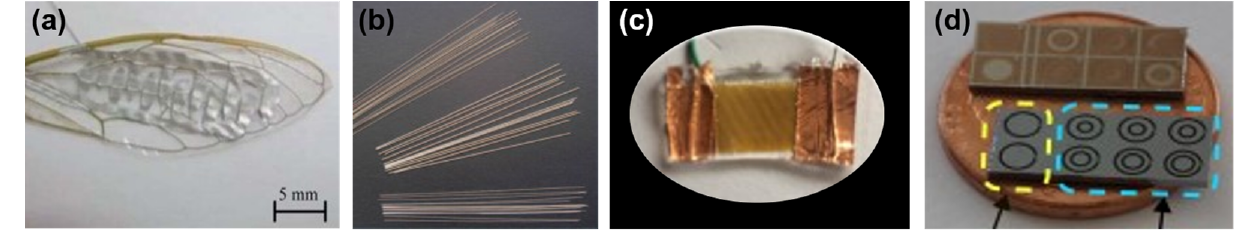
Figure 6. ( a ) Piezoelectric fibers on cicada wings. Reprinted with permission from Ref. [57]. Copyright 2014, Royal Society of Chemistry. ( b ) PZT microfibers. Reprinted with permission from Ref. [58]. Copyright 2012, Elsevier. ( c ) Piezoelectric nanogenerator (PENG). Reprinted with permission from Ref. [59]. Copyright 2019, MDPI. ( d ) Concentric ring boss harvesters (CRBH). Reprinted with permission from Ref. [61]. Copyright 2017, Springer.